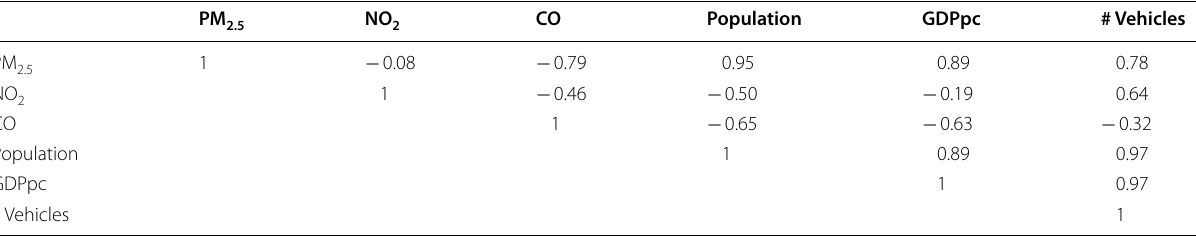
All correlations are significant with p values <